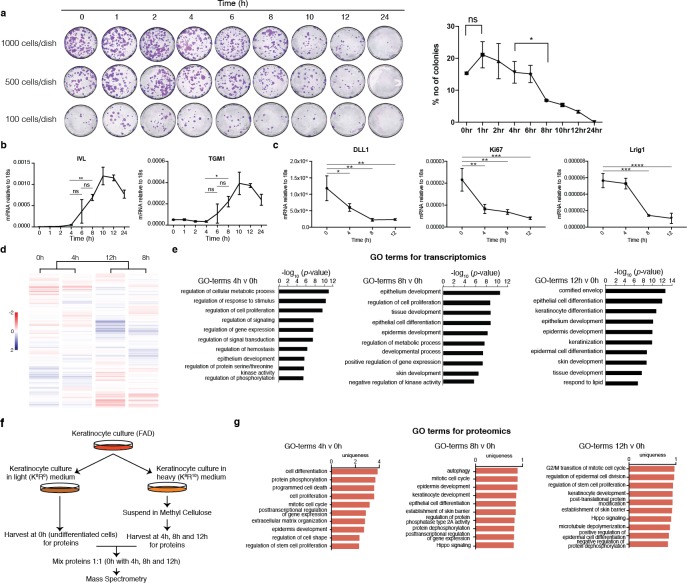
Clonal growth, genomic and proteomic analysis of suspension-induced terminal differentiation.(a) Keratinocytes harvested after 0, 1, 2, 4, 6, 8, 10, 12 or 24 hr in suspension in methylcellulose were seeded at 100, 500 or 1000 cells in 10 cm2 culture dish on mitotically inactivated J2 3T3 feeders and cultured for 12 days. Following staining, colonies were counted using ImageJ (n = 2 independent experiments with three replicate dishes per experiment; p-value calculated by two tailed t-test). (b) RT-qPCR quantification of IVL and TGM1 mRNA levels at different times in suspension (n = 3 independent cultures; p-value calculated by two tailedt-test). (c) RT-qPCR quantification of DLL1, Ki67 and Lrig1 mRNA levels at different times in suspension (n = 3 independent cultures; p-value calculated by one-way ANOVA). (d) Hierarchical clustering of significantly expressed transcripts at 0, 4, 8 and 12 hr in suspension (each time point represents the mean value of n = 3 independent experiments). (e) GO analysis of differentially expressed genes upregulated at 4, 8 and 12 hr relative to 0 hr. The bar plots represent –log10 of p-values of the identified GO terms. (f) Schematic of SILAC-Mass Spectrometry labelling protocol. (g) GO analysis of proteins ranked in the order of their expression level (fold increase relative to 0 hr) at 4, 8 and 12 hr. GO terms were fetched for individual proteins rather than for clusters of proteins. Bar plots represent –log10 of the p-values of the identified GO terms. (a–c) Error bars represent s.d. *p<0.05; **p<0.01; ***p<0.005; ns = non significant.